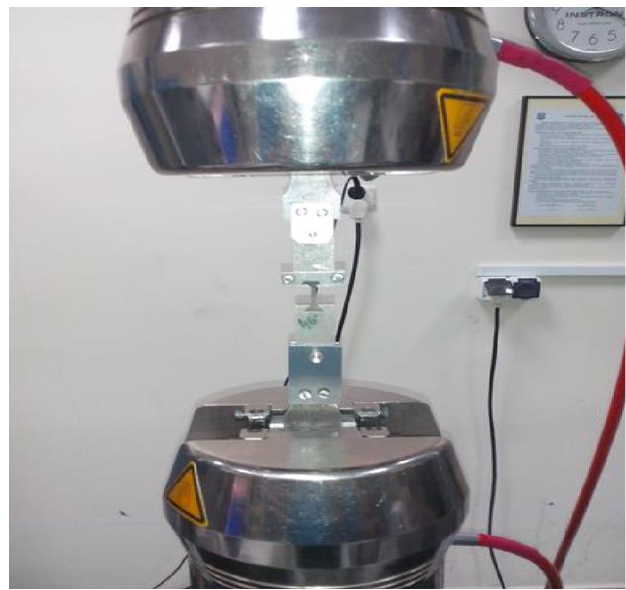
Figure 9. View of the test sample in specially designed holders.